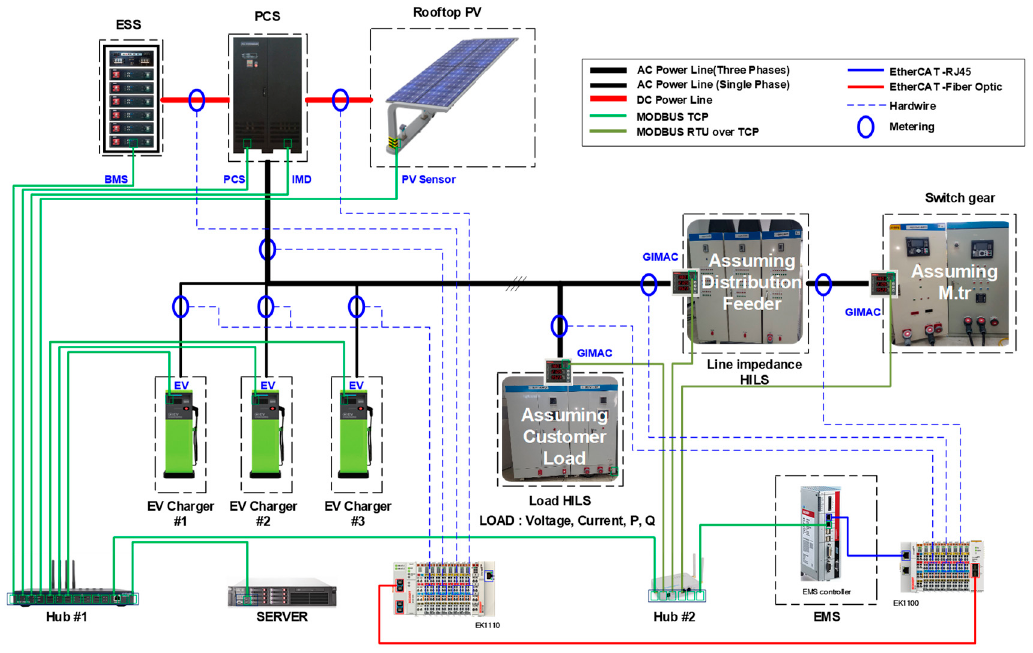
Figure 7. Electric vehicle charging infra linked with PHILS.